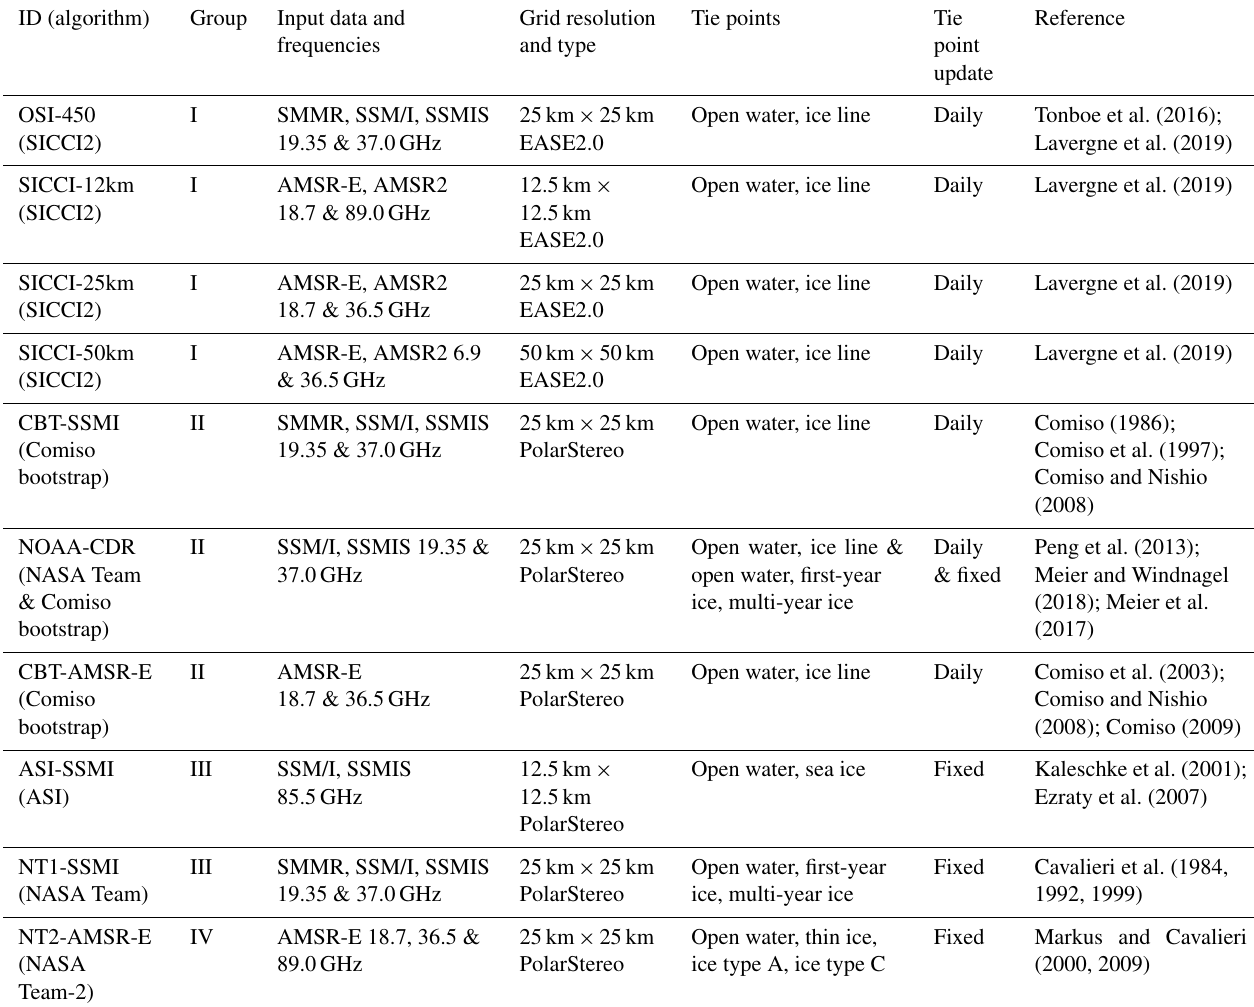
Table 1. Overview of the investigated sea-ice concentration products. Column “ID (algorithm)” holds the identifier we use henceforth to refer to the data product and which algorithm it uses. Group is an identifier for the algorithm concept used. Column “Input data” refers to the input satellite data for the data set. Columns “Tie points” and “Tie point update” refer to the type of tie points used and their update interval (see text for further